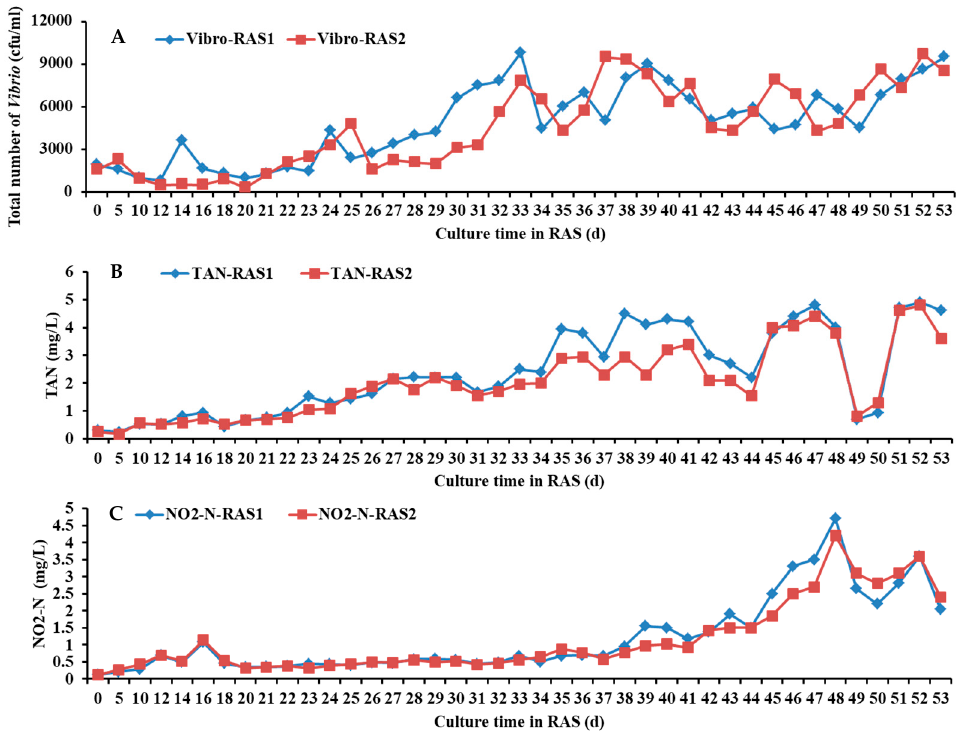
Figure 7. Changes in the total number of Vibrio ( A ), total ammonia nitrogen (TAN) ( B ), and nitrite nitrogen (NO 2 -N) ( C ) in the culture tanks during the recirculating aquaculture period.